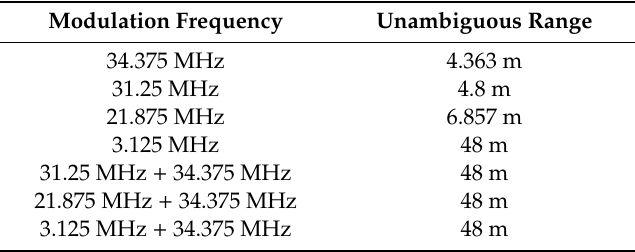
Table 2. Unambiguous ranges of each frequency combination Modulation Frequency